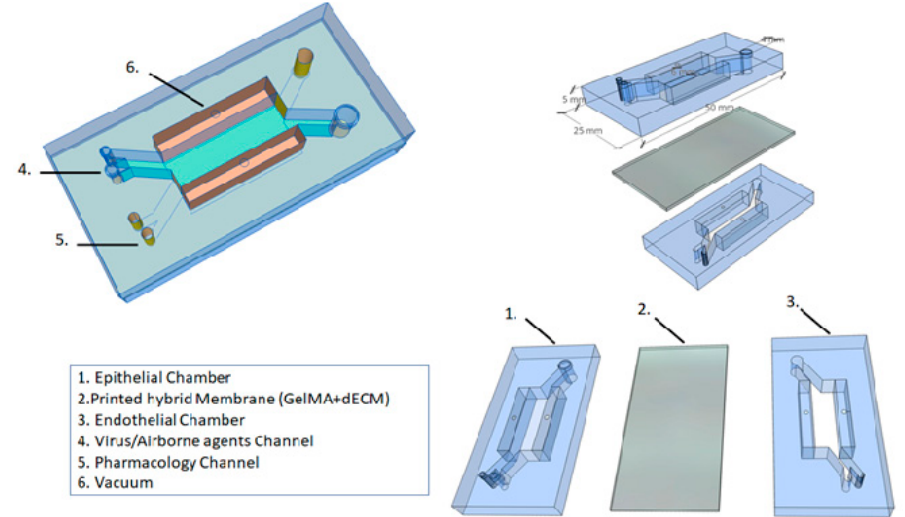
Figure 3. Alveolar lung-on-chip